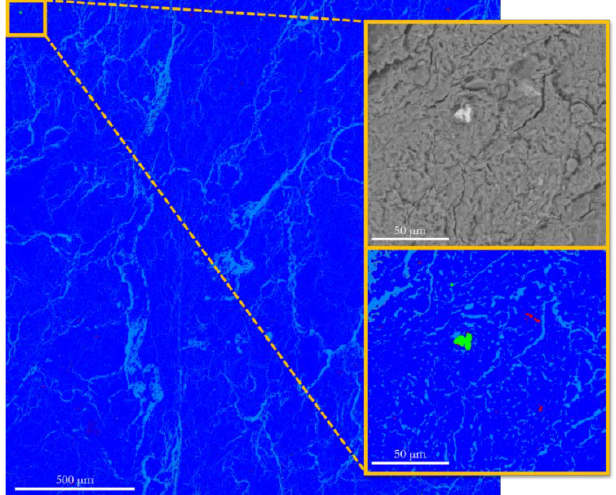
Figure 4. 2D montage over a 2 mm × 2 mm area in UC-03. False color image of segmented phases from processing in PerGeos: light blue—pore spaces and organic matter; dark blue—matrix material (e.g., clay and quartz); red—high-density minerals (e.g., pyrite, zircon); green—REE-bearing minerals. Insets show BSE (top) and false color (bottom) images of a magnified region containing a monazite crystal.